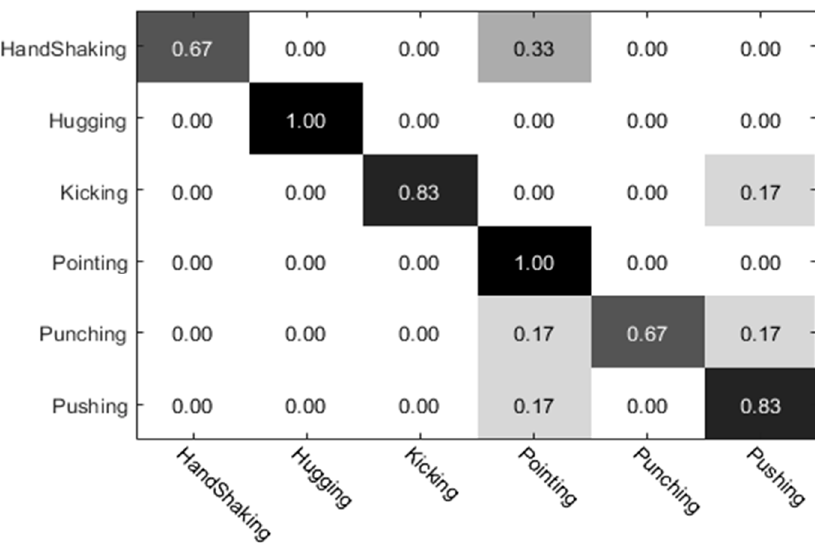
Figure 10. Individual video (left) classification results.